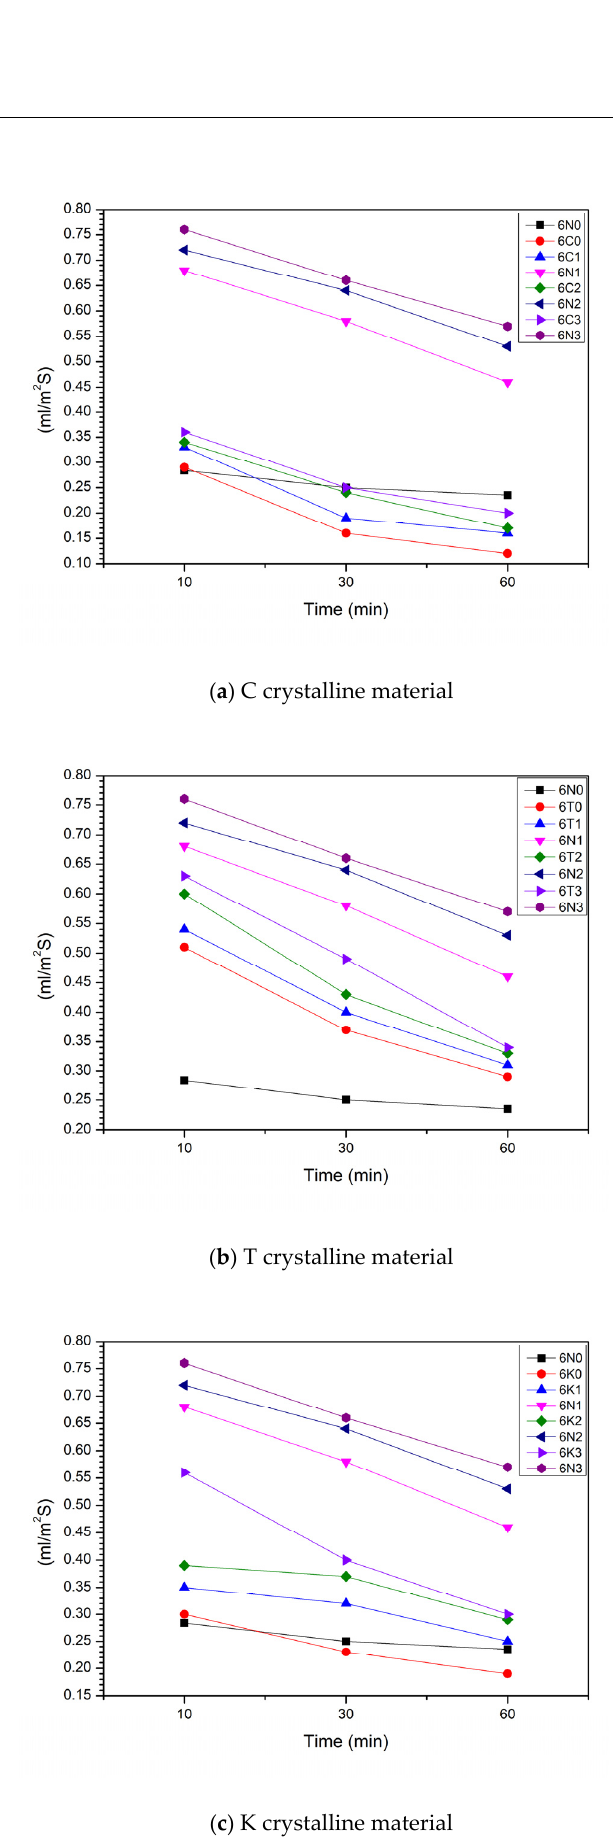
Figure 9. Initial surface water absorption of cement mortar after 28 days when W/C = 0.6.